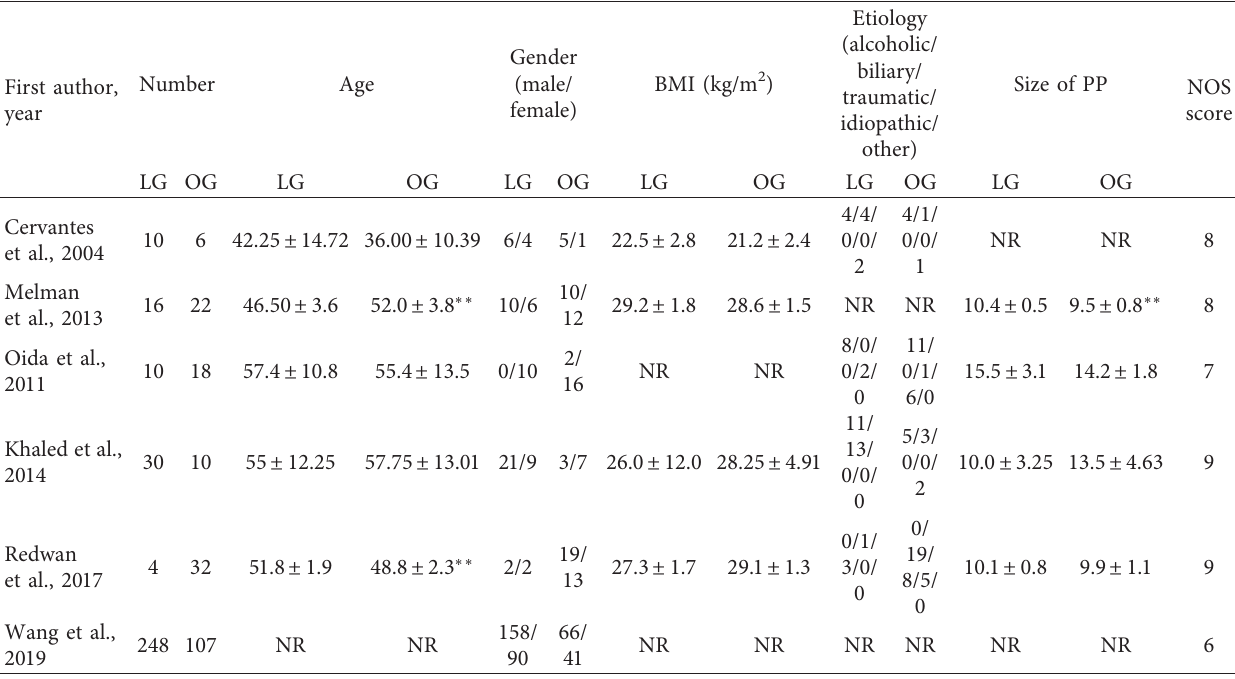
Table 1: Baseline characteristics and demographics of patients